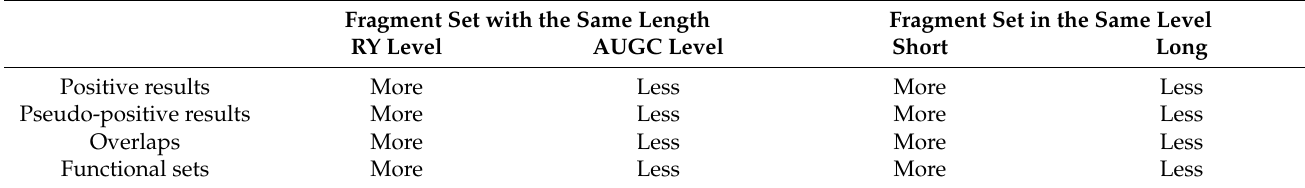
Table 3. Comparisons of two strategies and different